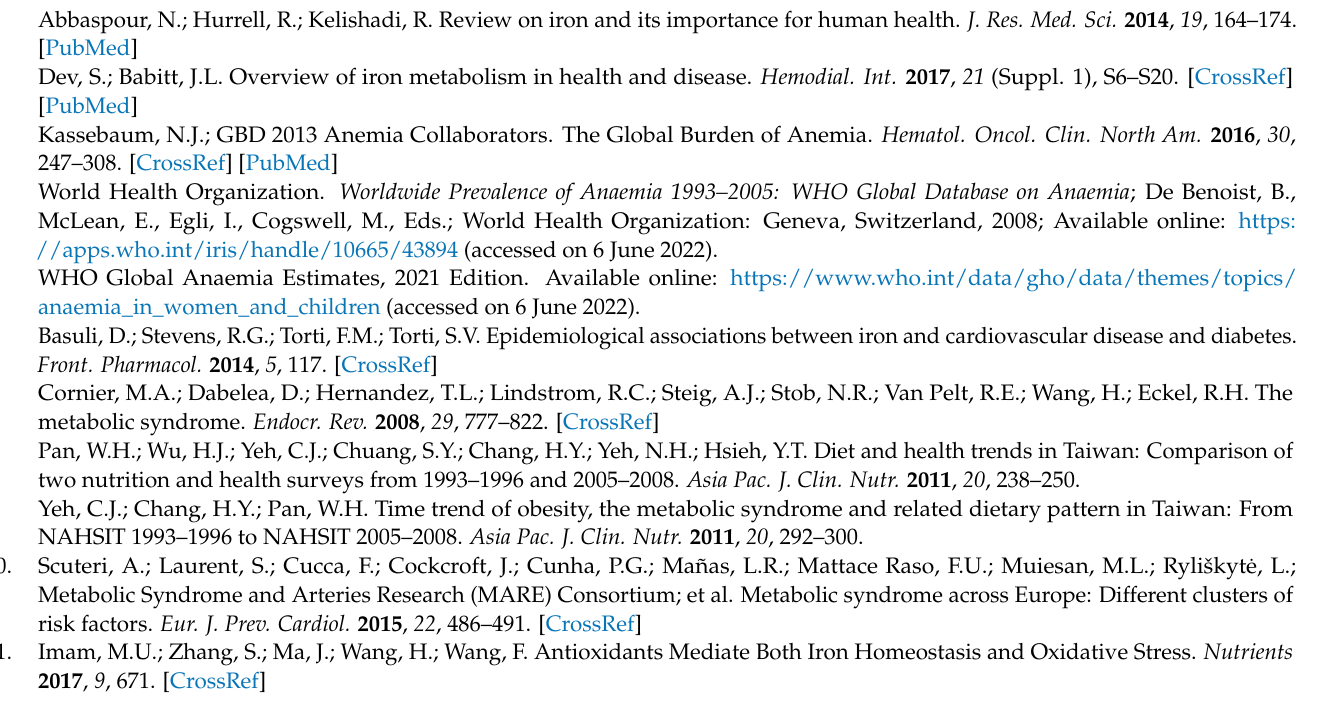
increasing deciles of Hb levels among Taiwanese Han Chinese; Table S19: Odds ratios of hypercholes- terolemia across increasing deciles of Hb levels among European Whites; Table S20: Odds ratios of gout across increasing deciles of hemoglobin levels among Taiwanese Han Chinese; Table S21: Odds ratios of gout across increasing deciles of hemoglobin levels among European Whites; Table S22: Odds ratios of diabetes across increasing deciles of hemoglobin levels among Taiwanese Han Chinese; Table S23: Odds ratios of diabetes across increasing deciles of hemoglobin levels among European Whites; Tables S24.1–S24.8: With BMI as additional covariate in the